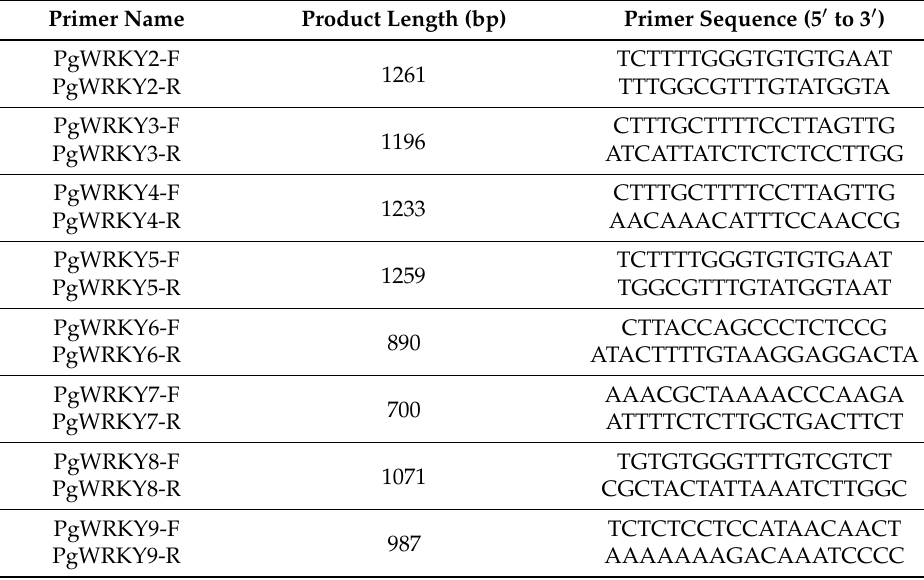
Table 2. List of primers used for cloning of eight PgWRKYs ( PgWRKY2-9